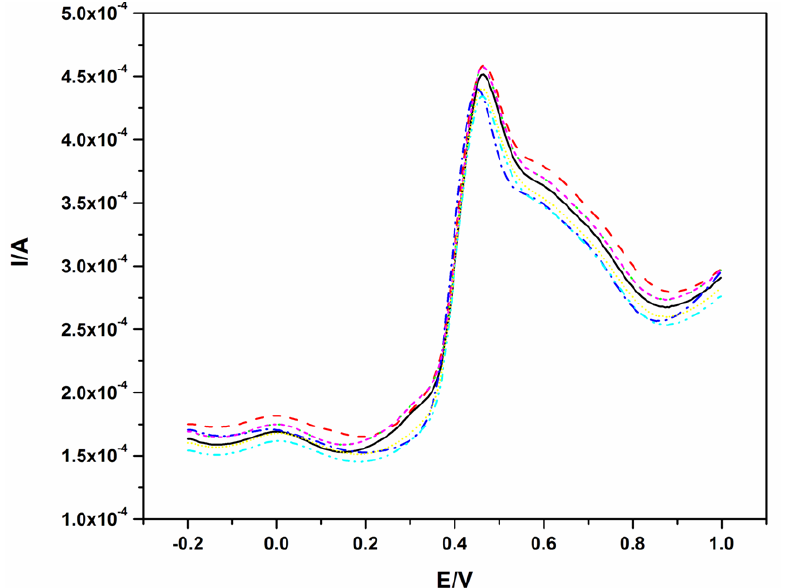
Figure 5. Seven SWVs of 40 µM BPA in phosphate buffer solution at pH